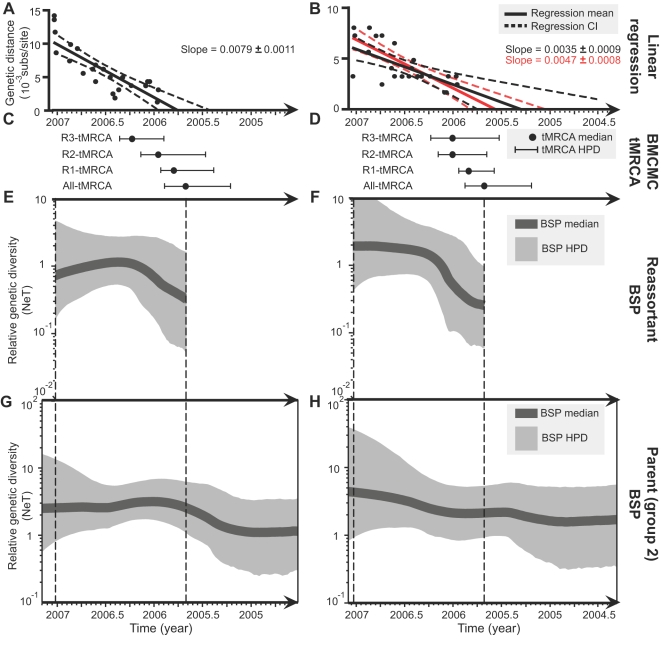
Estimation of tMRCA and relative genetic diversity for reassortant viruses and its genetic parent (group 2).(A) and (B) show the plots of the genetic distance from MRCA to each reassortant taxa, and the linear regression line depicting the tMRCA for HA and NA genes, respectively. 95% confidence intervals are shown by dashed lines. Red dots and regression line indicate the removal of two sequences from the NA dataset. (C) and (D) show the tMRCAs estimated respectively from HA and NA genes using the BMCMC method. 95% higher probability density (HPD) is shown by the error bar. (E) and (F) show the Bayesian Skyline plots (BSP) illustrating the change of relative genetic diversity of reassortant viruses through time estimated from the HA and NA gene datasets, respectively. (G) and (H) show the BSP for group 2 viruses estimated from HA and NA gene datasets, respectively.